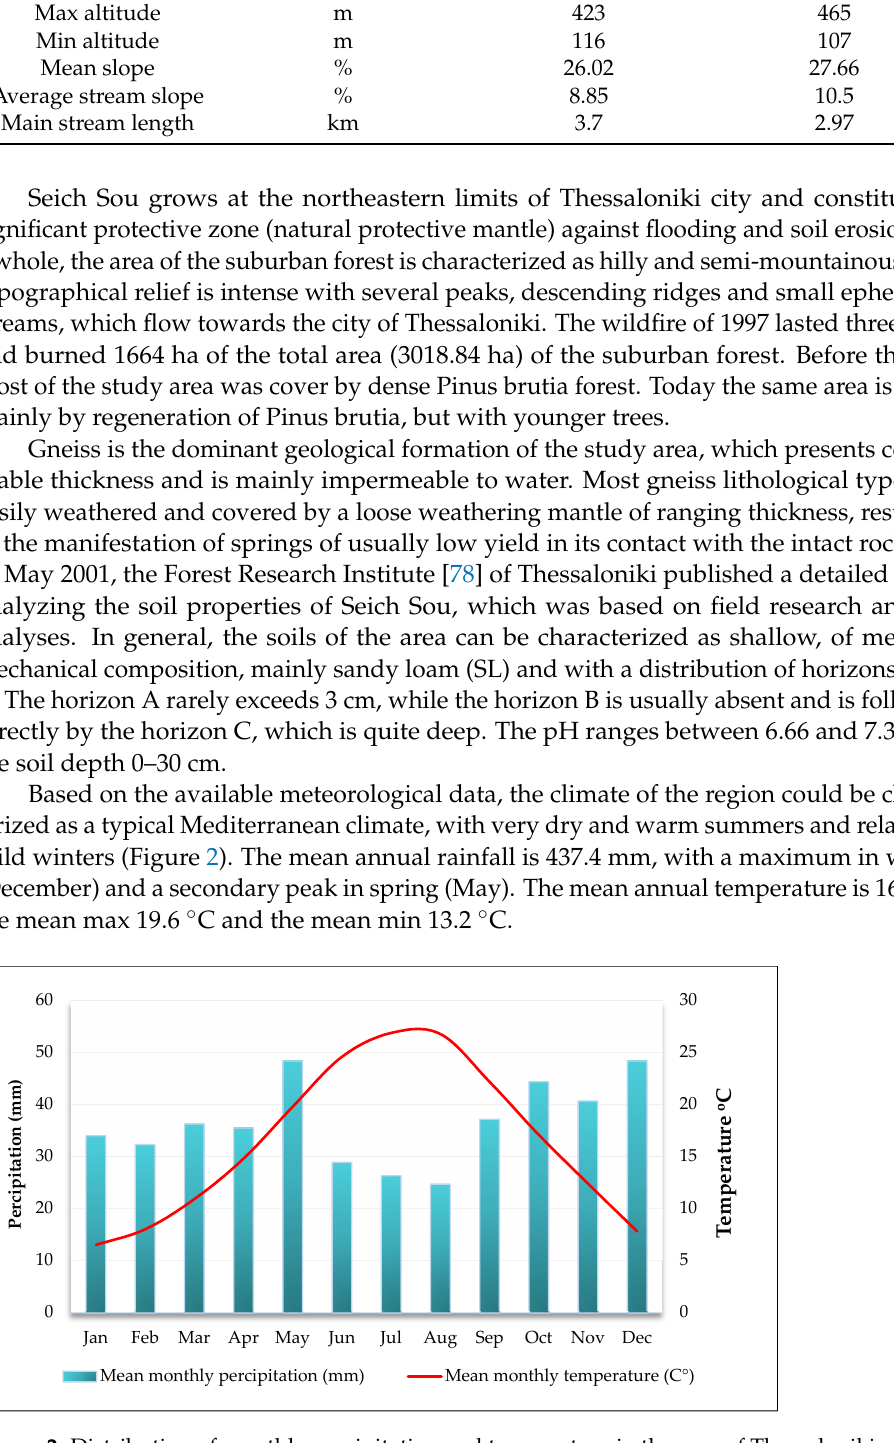
Figure 2. Distribution of monthly precipitation and temperature in the area of Thessaloniki.